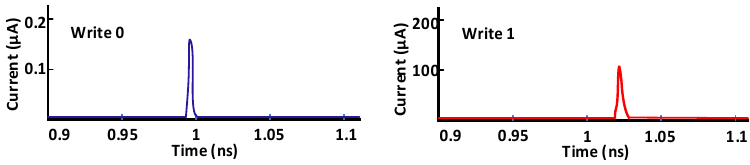
Figure 22. Write current flow information 6T-SRAM cell for internal data sneaking [74].